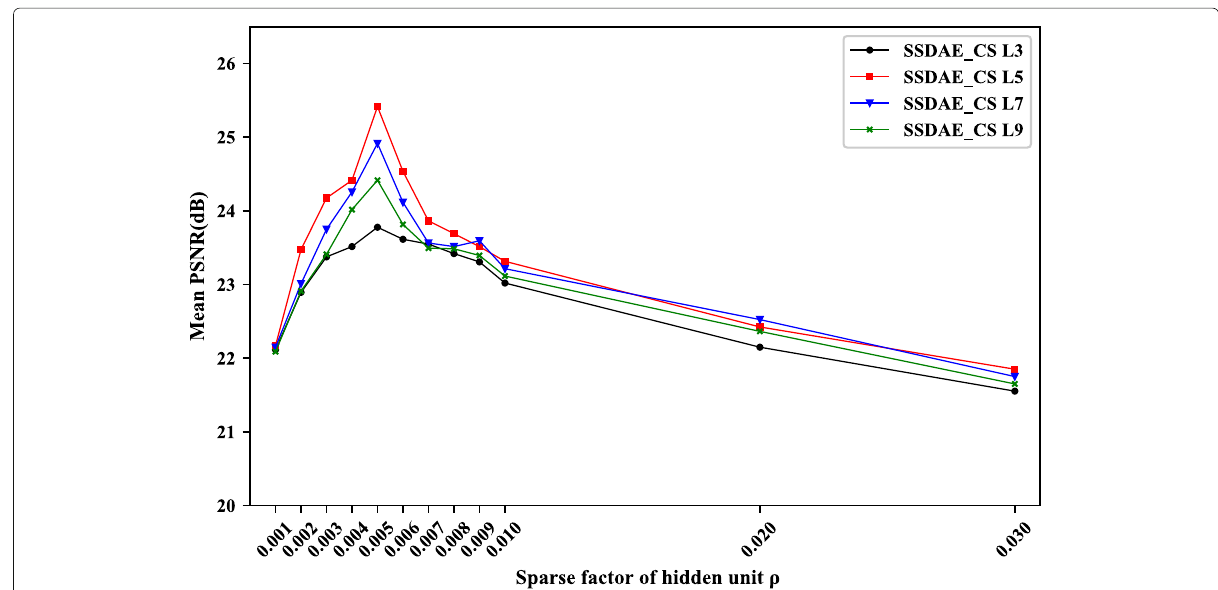
Fig. 4 The variation tendency of mean PSNR with different sparse